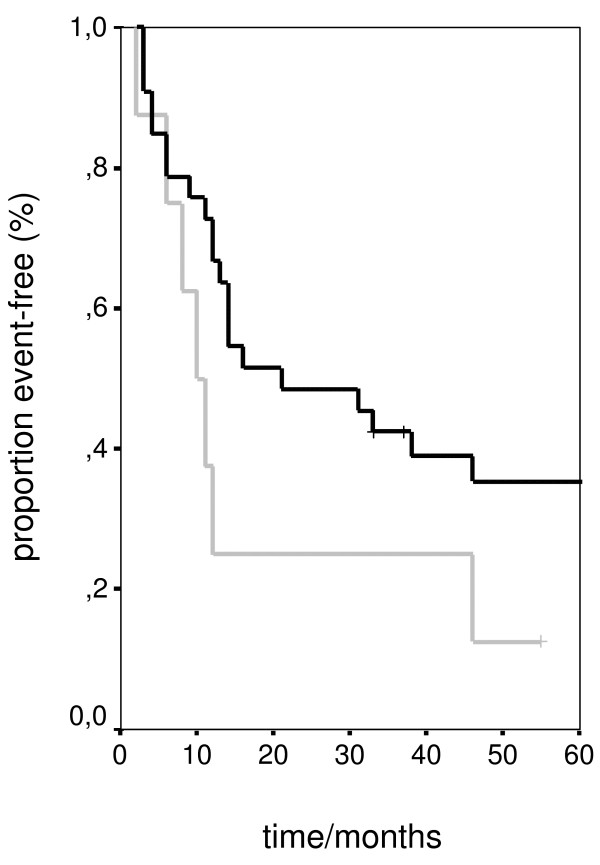
Relapse-free survival for patients with preoperative (grey line) versus postoperative radiotherapy (black line).